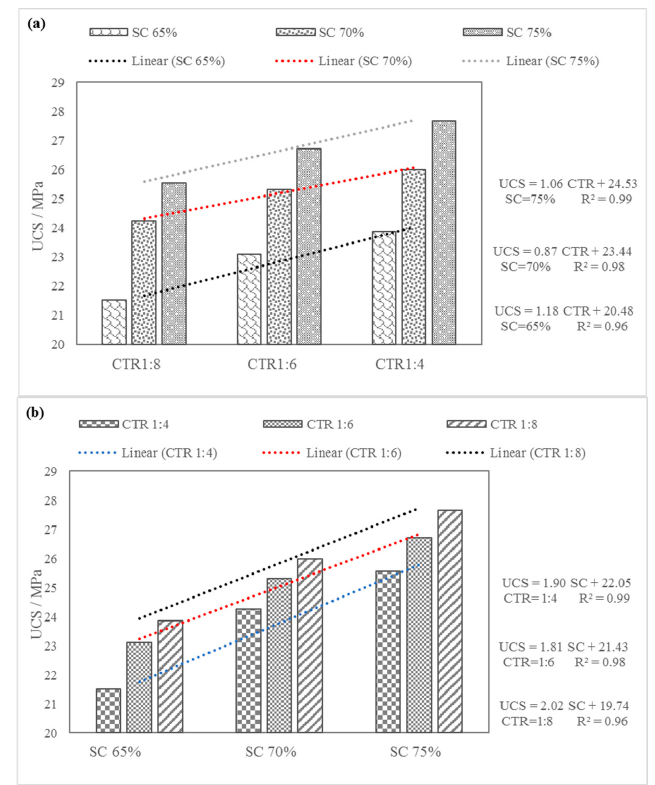
Figure 11. Relationship of the CTR and SC on the UCS values of the CTB-RC specimens: ( a ) Relationship curve between the UCS values and CTR. ( b ) Relationship curve between the UCS values and SC. Table 5. The UCS values of different types of specimens.